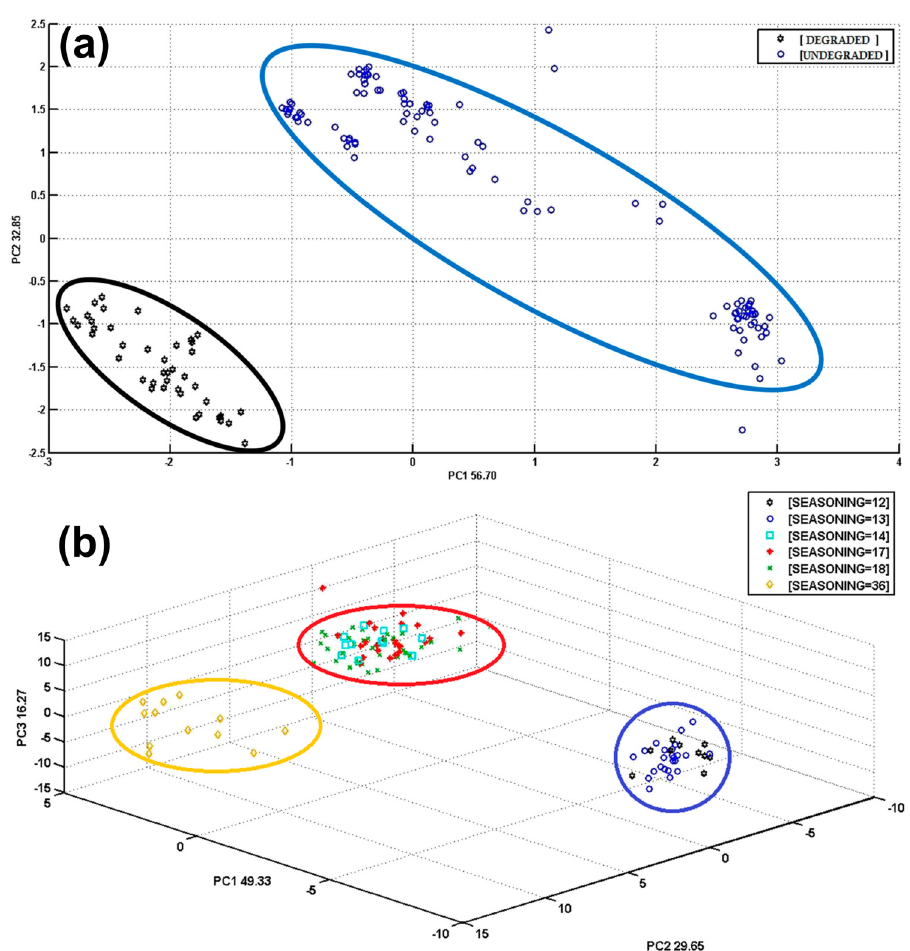
Figure 10: ( a ) PCA plot of degraded and undegraded cheese samples in black and blue, respectively. ( b ) PCA of cheese samples with di ff erent ripening times ( in months ) . Edited with permission from ref. [ 66 ]